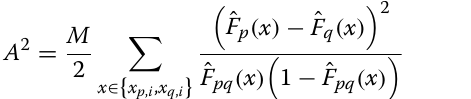
The blue circles represent individual SAR acquisitions, and the lines connecting them represent the pairs from which small baseline interferograms are formed. The red lines in ( b ) and ( c ) indicate pairs with temporal separation less than 60 days and the green lines indicate those less than 400